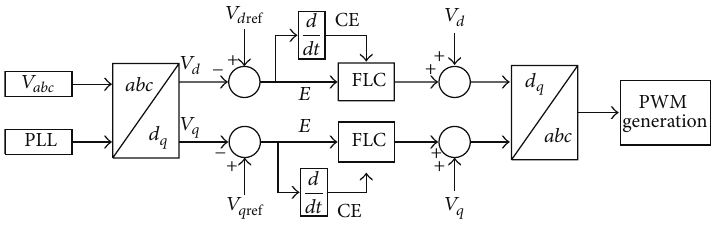
Figure 2: Architecture of the voltage control strategy.